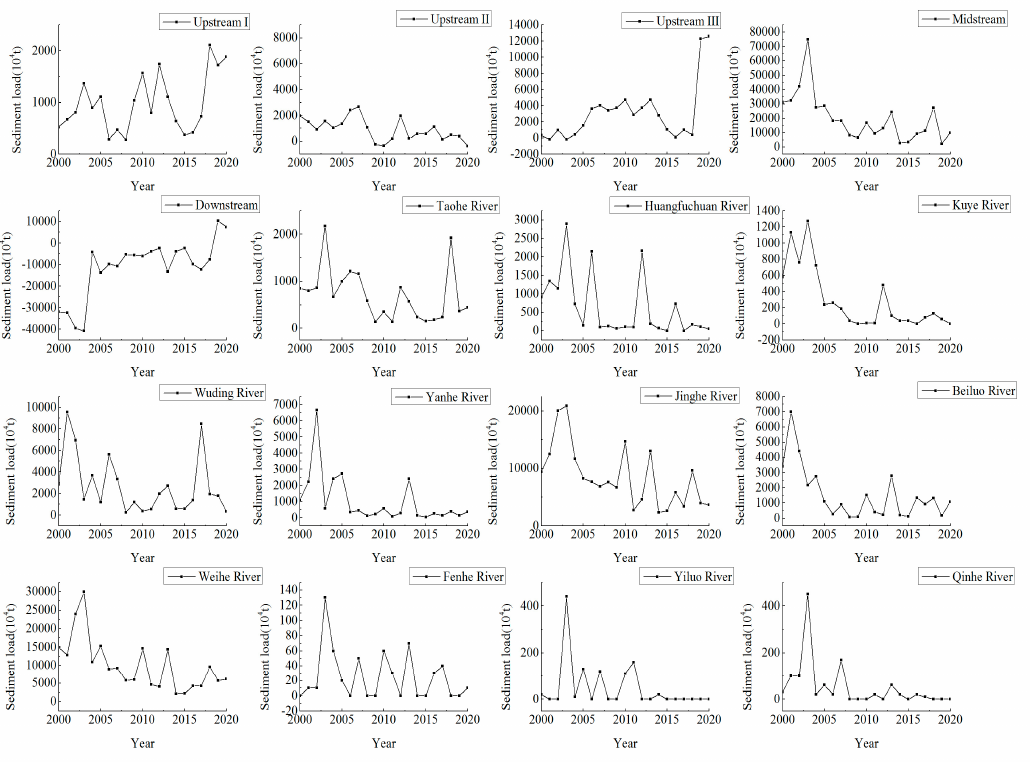
Figure 6. Dynamic changes in the sediment load in the Yellow River basin; this figure includes the change in sediment load in each division of the main stream and tributaries.